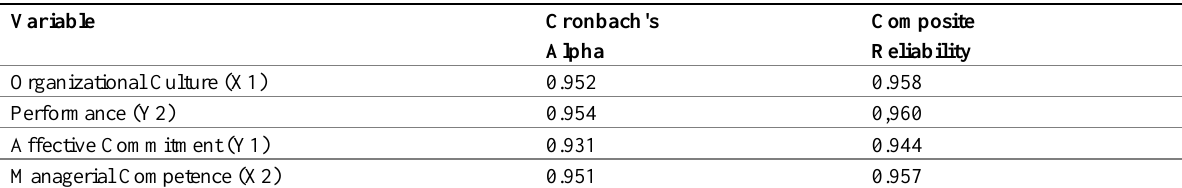
Table 17: Cronbach's Alpha and Composite Reliability Values